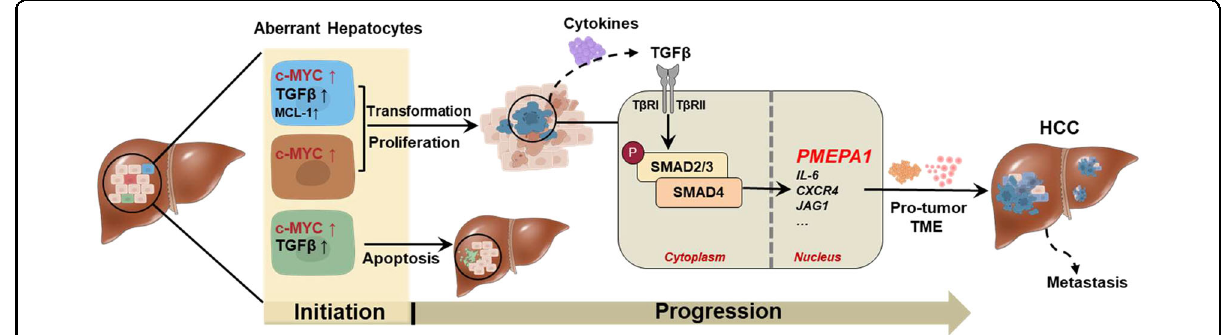
Fig. 8 Scheme showing the role of TGF β -SMAD signaling in the regulation c-Myc induced hepatocarcinogenesis. Abbreviation: TME, tumor